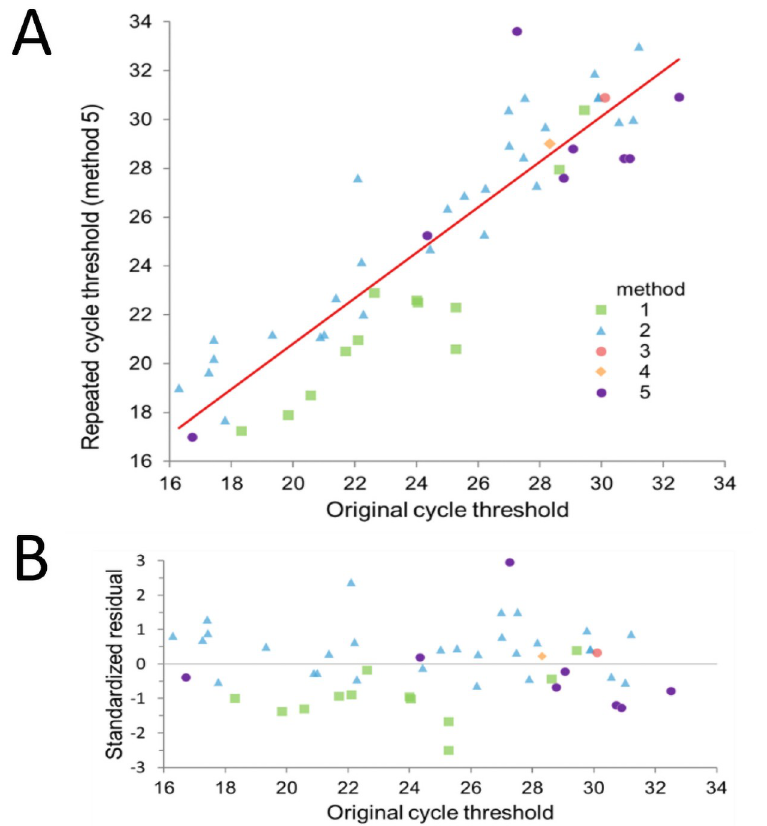
Fig 1. Scatter plot A) and Residual plot B) of the original and repeated Ct values. Colour codes indicate the original testing